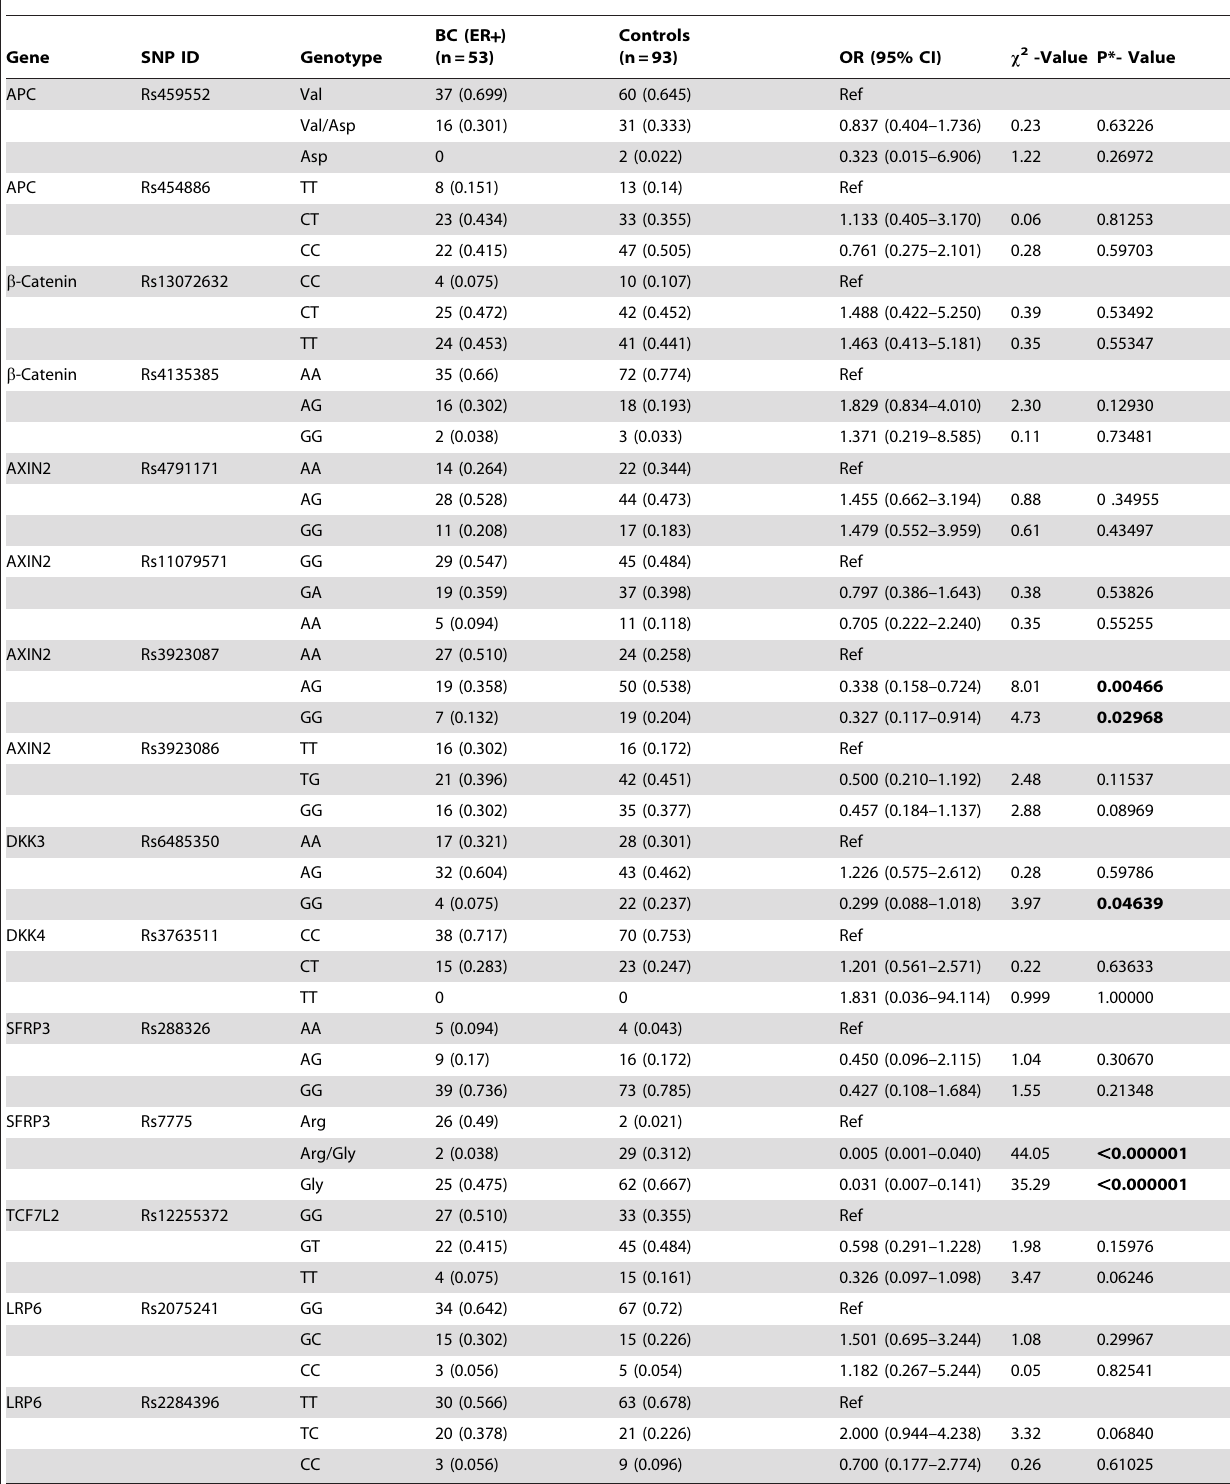
Table 5. Comparison of genotype frequencies of SNPs in Wnt pathway genes between ER + breast cancers versus controls.